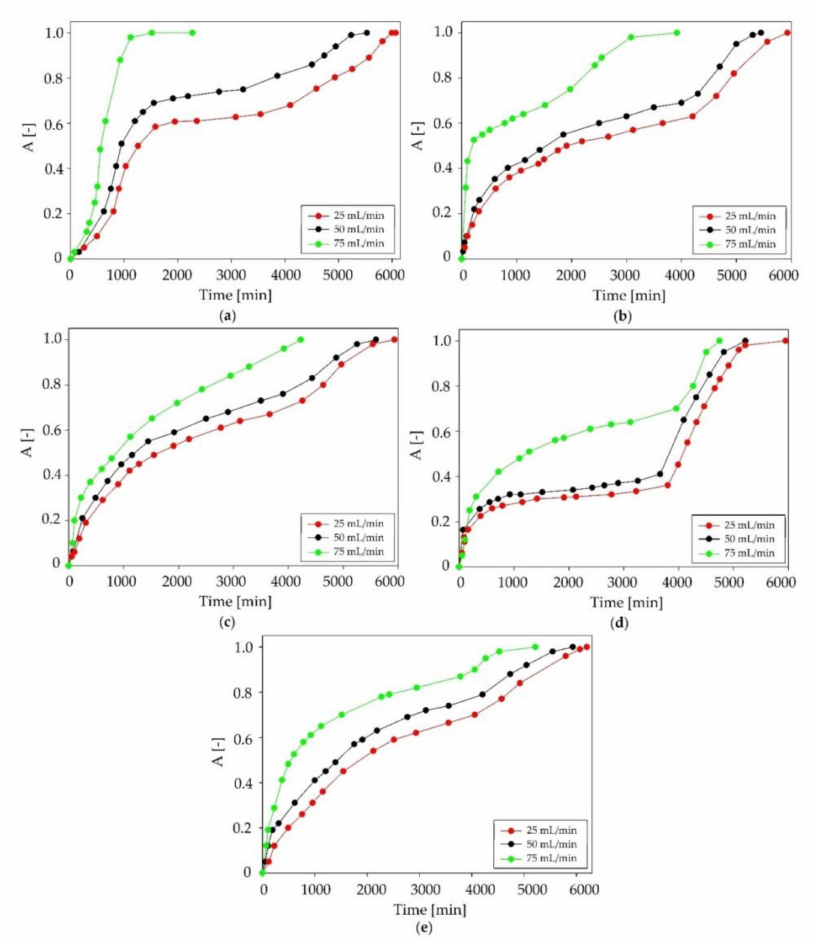
Figure 10. Absorption curves of C:DA (1:1) at various biogas flow rates in the range of 25–75 mL/min for individual siloxanes: ( a ) L2, ( b ) L3, ( c ) L4, ( d ) D3 and ( e )